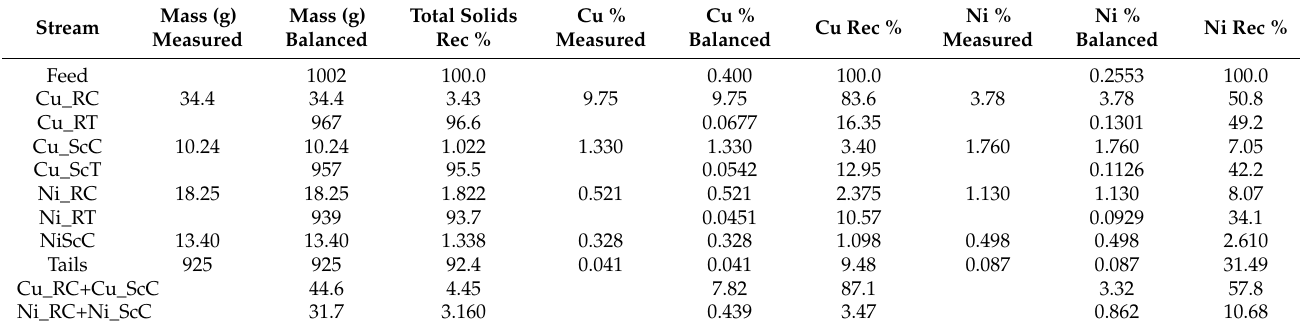
Table A2. Mass balance for flotation test Sep 08_02.